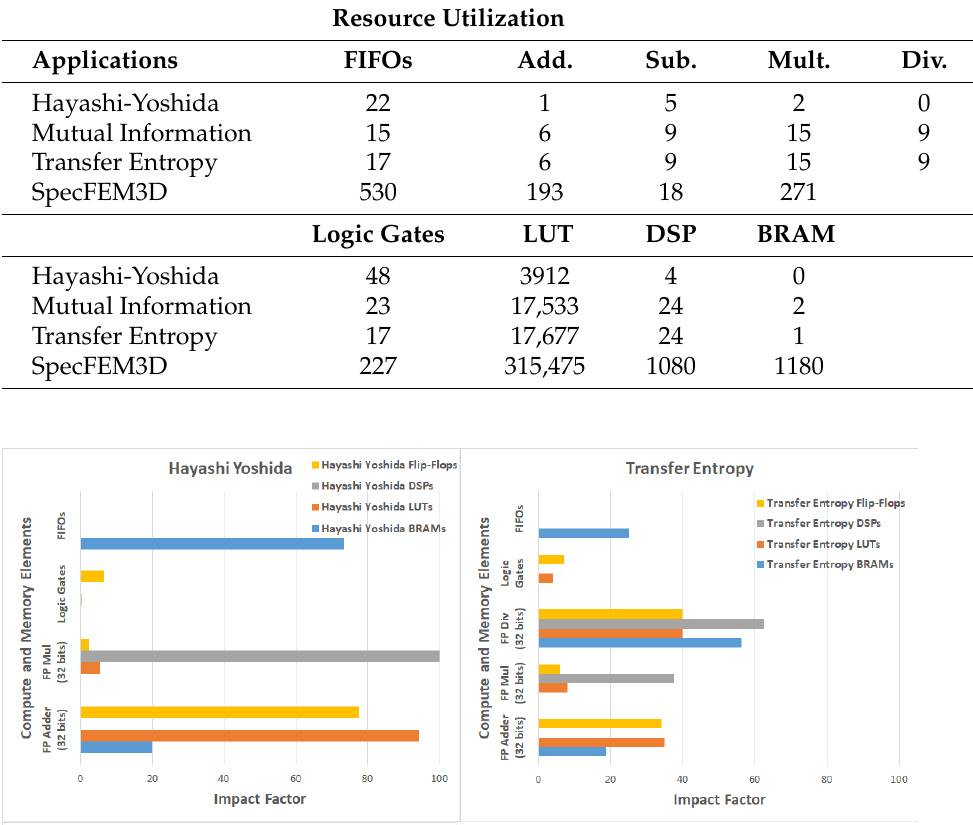
Table 1. Synthesis (Dataflow Graph (DFG) nodes) and Overall (FPGA resources) resource utilization for each application.